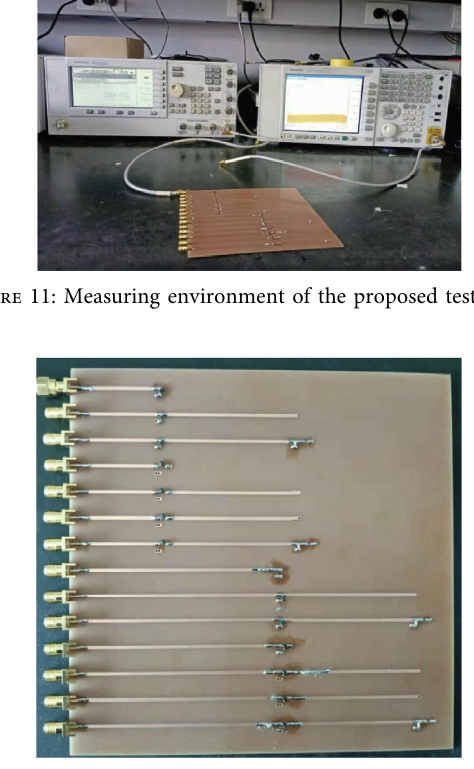
Figure 12: Photograph of the fabricated test board.